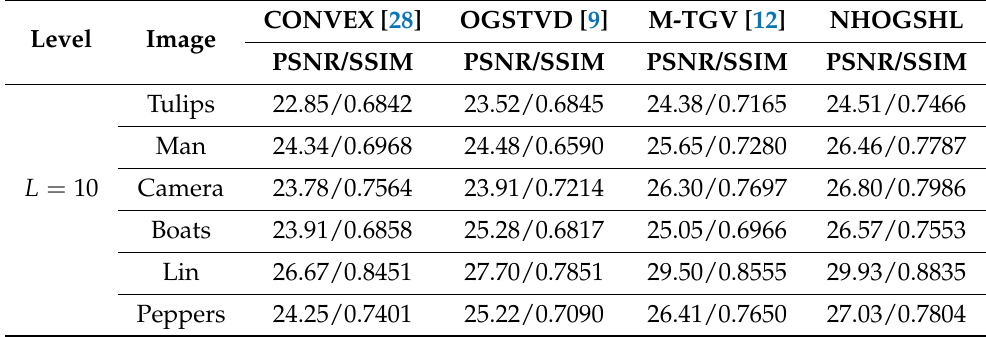
Table 3. Summary of the results of PSNR values and SSIM values restored by different algorithms under the noise level of L =